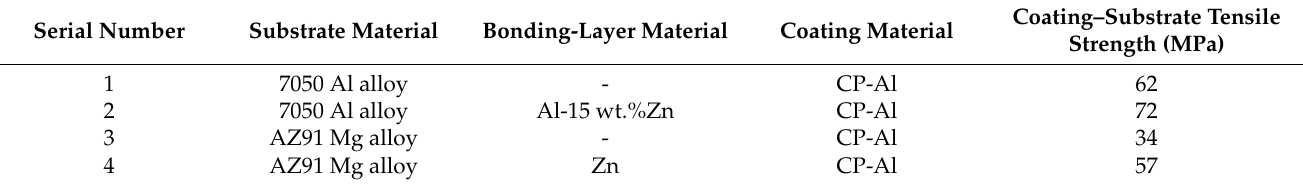
Table 4. Matrix-coating interface bonding strength